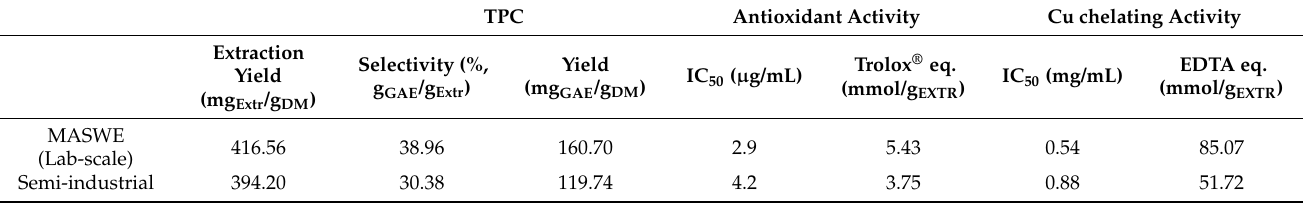
Table 7. Lab-scale and semi-industrial scale SWE comparison. Extraction yield, TPC, antioxidant, and chelating